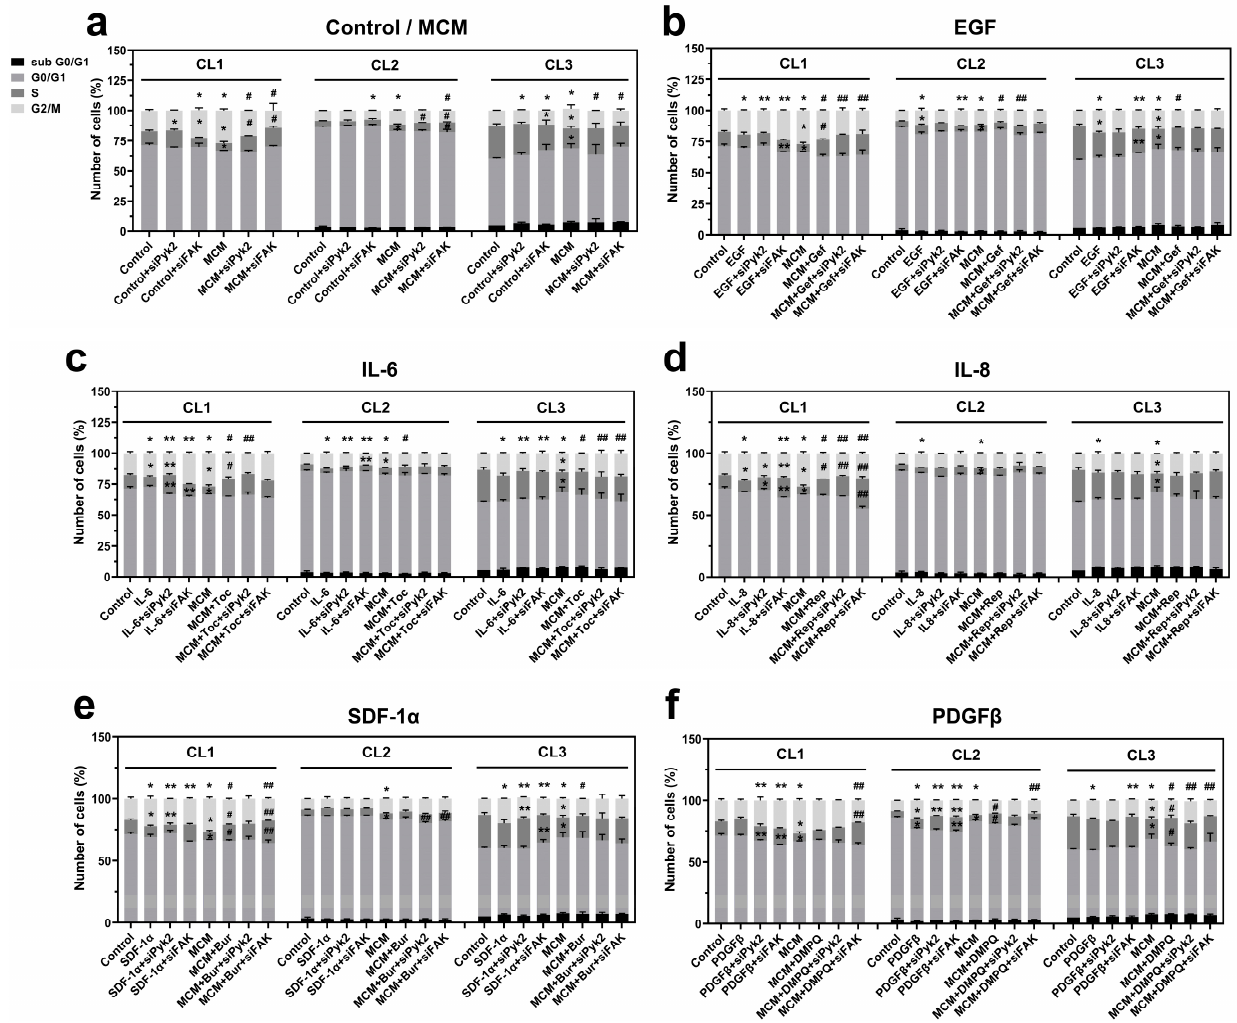
Figure 6. Glioma cell mitosis is stimulated by microglia-derived cytokines through Pyk2 and FAK signaling. Cell cycle analysis was performed to evaluate glioma cell proliferation with flow cytometry. The percentage of cells in the sub-G0/G1, G1, S, and G2/M phases was determined by DNA content in ( a ) control and microglia-conditioned medium (MCM)-, ( b ) EGF and gefitinib-, ( c ) IL-6 and tocilizumab-, ( d ) IL-8 and reparixin-, ( e ) SDF-1 α and burixafor-, and ( f ) PDGF β and DMPQ-treated CL1, CL2, and CL3 cells silenced for Pyk2 and FAK expression. The values are shown as means ± SD for 3–6 experiments per group. * p < 0.05 vs. control, ** p < 0.05 vs. MCM, # p < 0.05 vs. the corresponding cytokine, ## p < 0.05 vs. the corresponding inhibitor. Inh III, inhibitor III; Bur, burixafor; Toc, tocilizumab; Rep, reparixin; and Gef,